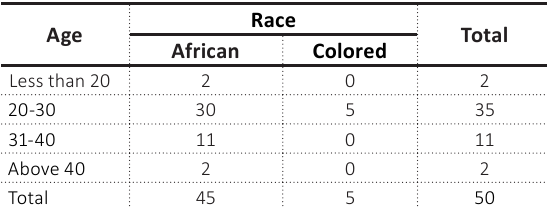
Table 3. Age and race distributions of